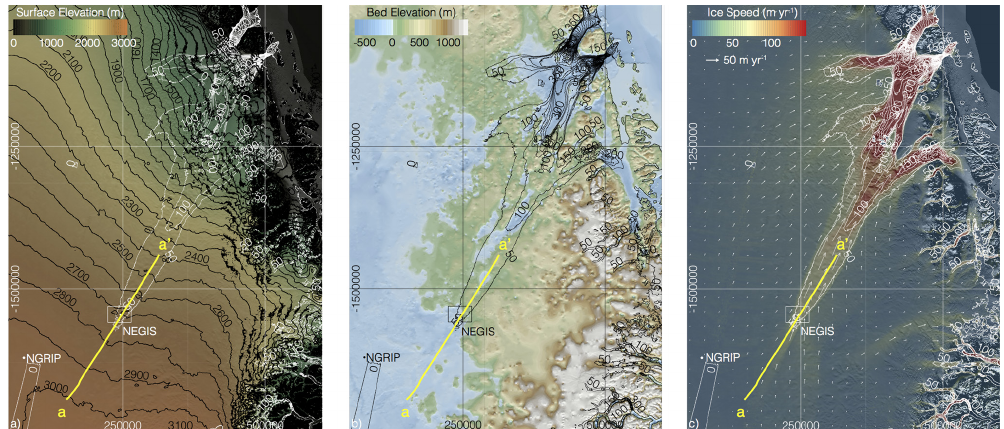
Figure 2. (a) Surface elevation, (b) bedrock elevation, and (c) ice velocity of northeast Greenland. Flow line aa’ is shown in Fig. 3. White (black in b ) box denotes area shown in Fig. 4. Surface elevation (black) and ice speed (white; black in b ) contour intervals are 100m and 50myr − 1 , respectively. Bed elevation is from Bamber et al. (2013). Velocities are derived from interferometric synthetic aperture radar data (Joughin et al., 2010). Background imagery is MODIS (T. Haran, personal communication, 2012).